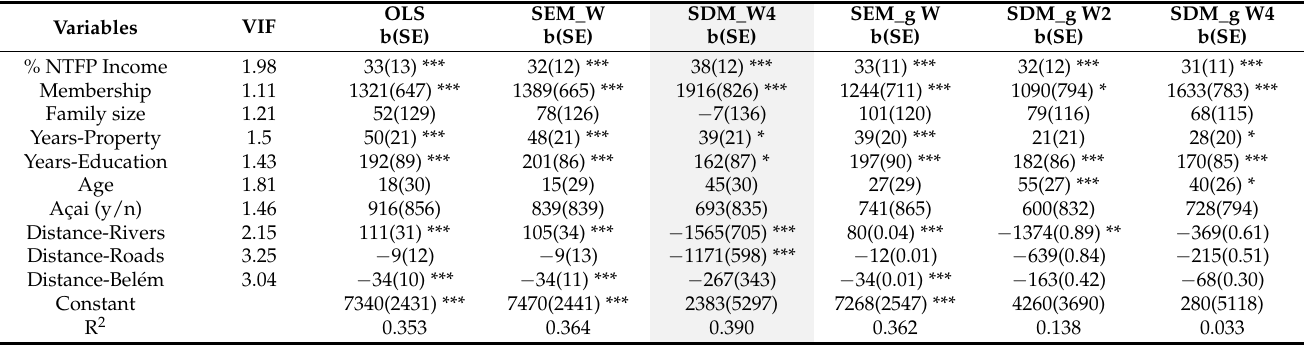
Table 5. VIF, OLS, and Spatial Regression Model